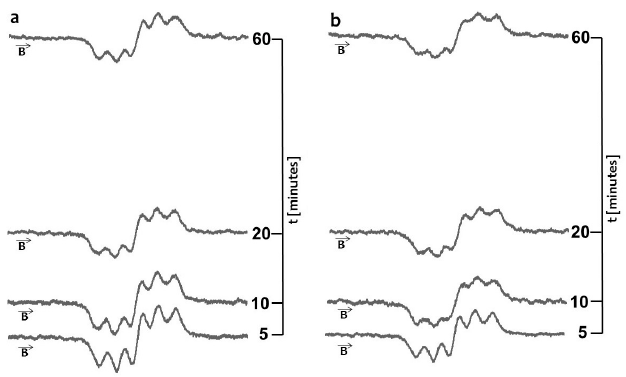
Figure 3. EPR spectra of DPPH interacting with ( a ) propolis drops and ( b ) propolis spray heated at the temperature 50 ◦ C for 5 min, 10 min, 20 min, 60 min. B —magnetic induction. Time of heating was 30 min.